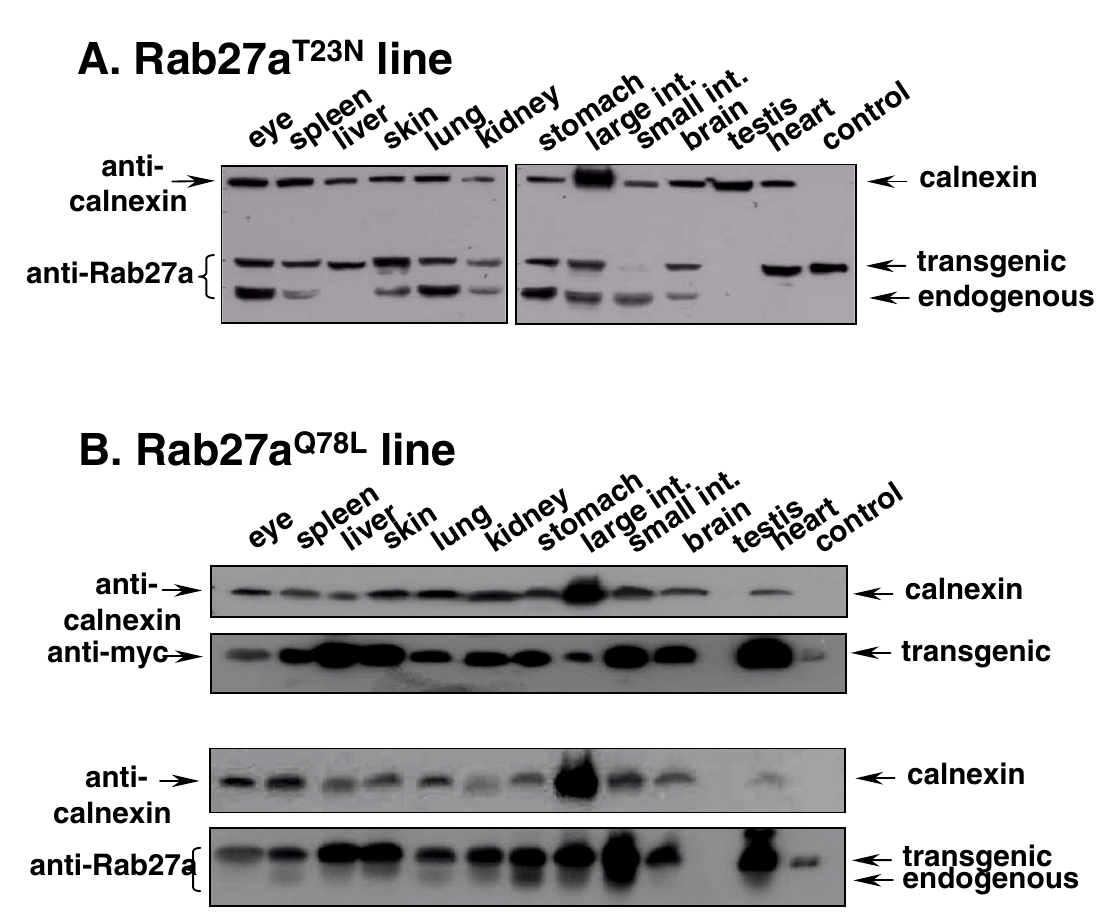
Figure 4 Expression of transgenic Rab27a proteins in mouse tissues. Protein extracts obtained from eyes, spleen, liver, skin, lung, kidney, stomach, large intestine, small intestine, brain, testis and heart (50 µ g each) were subjected to SDS-PAGE and probed with monoclonal anti-myc-tag antibody (9E10) and/or a specific anti-Rab27a monoclonal antibody (4B12). Calnexin was used as a loading control and detected using a specific polyclonal antibody. A protein extract of HeLa cells transfected with myc- Rab27a T23N was used as a positive control. (Panel A) Tissues from the A27aT25/2 line carrying Rab27a T23N . (Panel B) Tissues from the A27aQ24 line carrying Rab27a Q78L